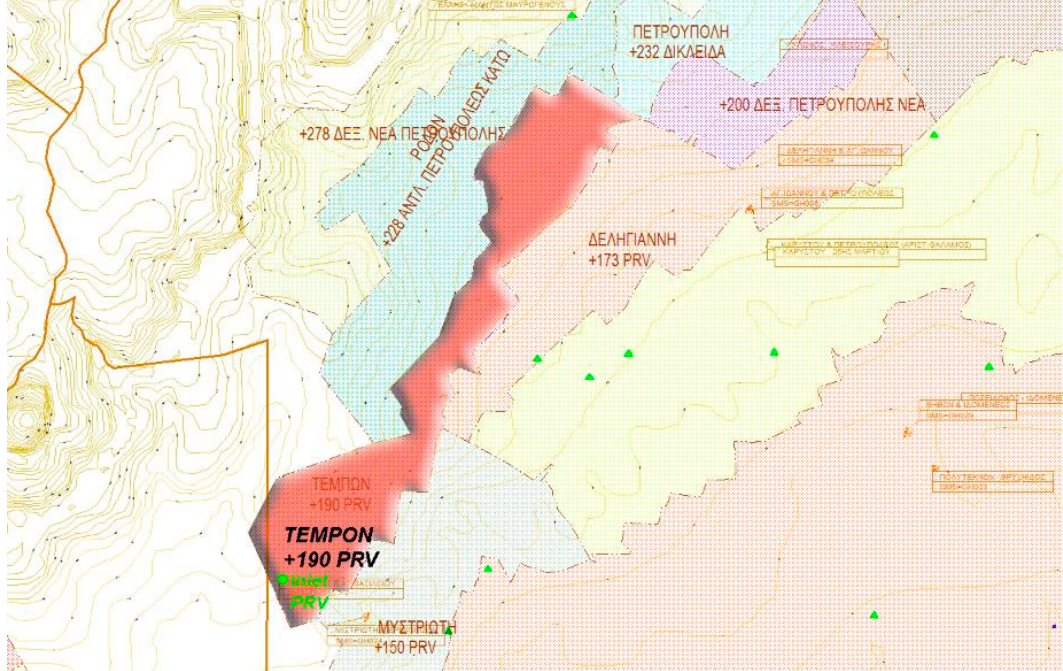
Figure 1. The selected Tempon +190 PRV